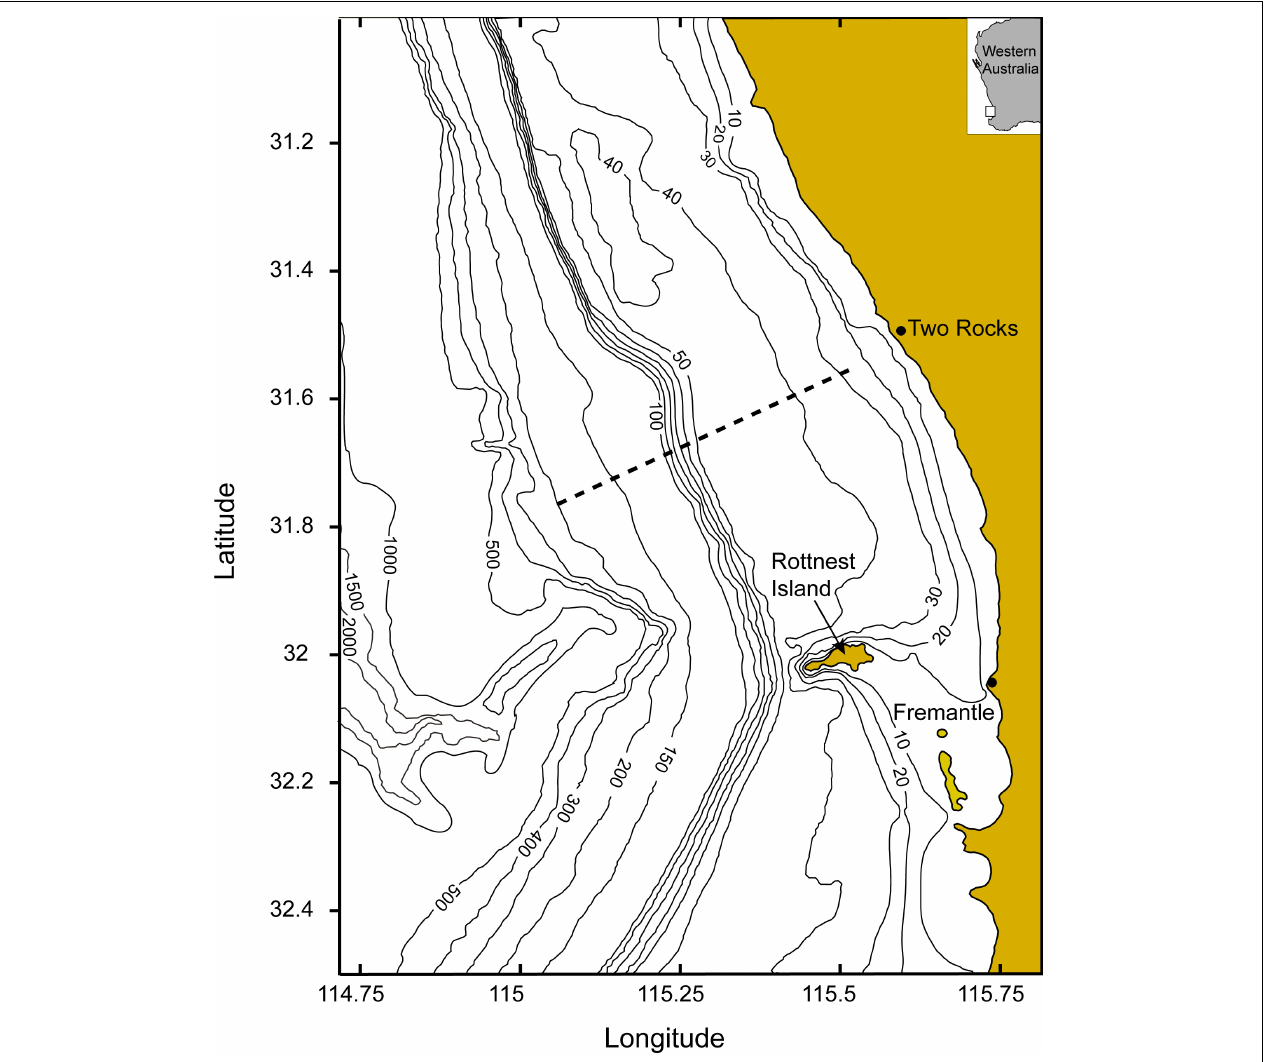
FIGURE 1 | Location of the study area and the glider transect. Bathymetric contours are in meters.